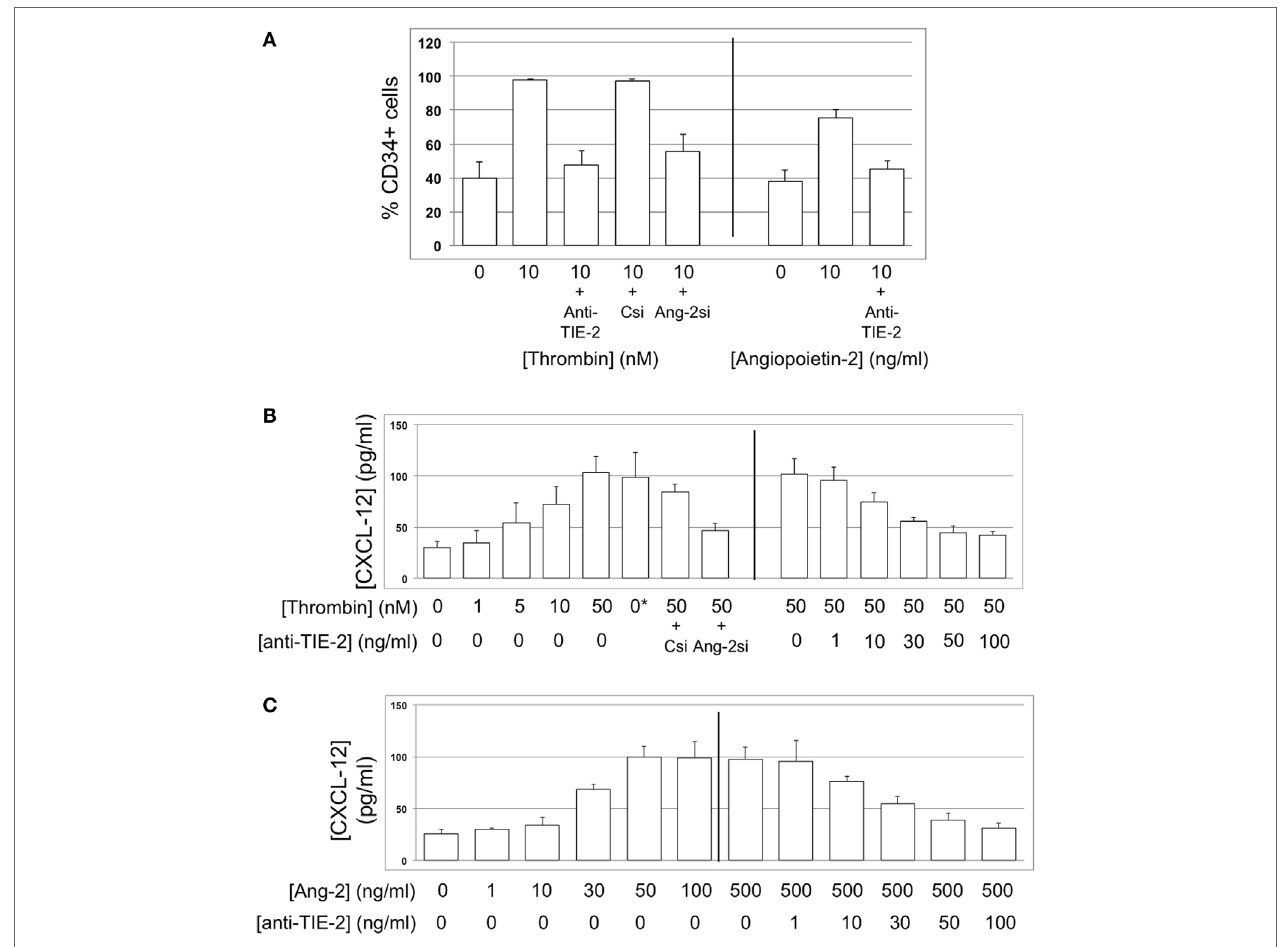
FigUre 13 | CXCL-12 expression is thrombin and angiopoietin-2-dependent. (a) Expression of CXCL-12 at baseline and after incubation with thrombin or angiopoietin-2 for 5 days, expressed as the percentage of cells staining positive in immunocytofluorescence analysis. Anti-TIE-2 antibody used at 50 ng/ml. (B) Secretion of CXCL-12 into supernatant after 5 day incubation with thrombin at the indicated concentrations, analyzed by ELISA. (c) Secretion of CXCL-12 into supernatant after 5 day incubation with angiopoietin-2 at the indicated concentrations, analyzed by ELISA. All data shown from WT CD34 +